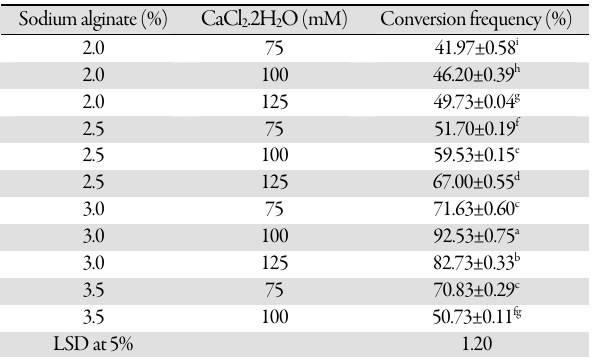
Table 3. Optimization of sodium alginate and CaCl 2 .2H 2 0